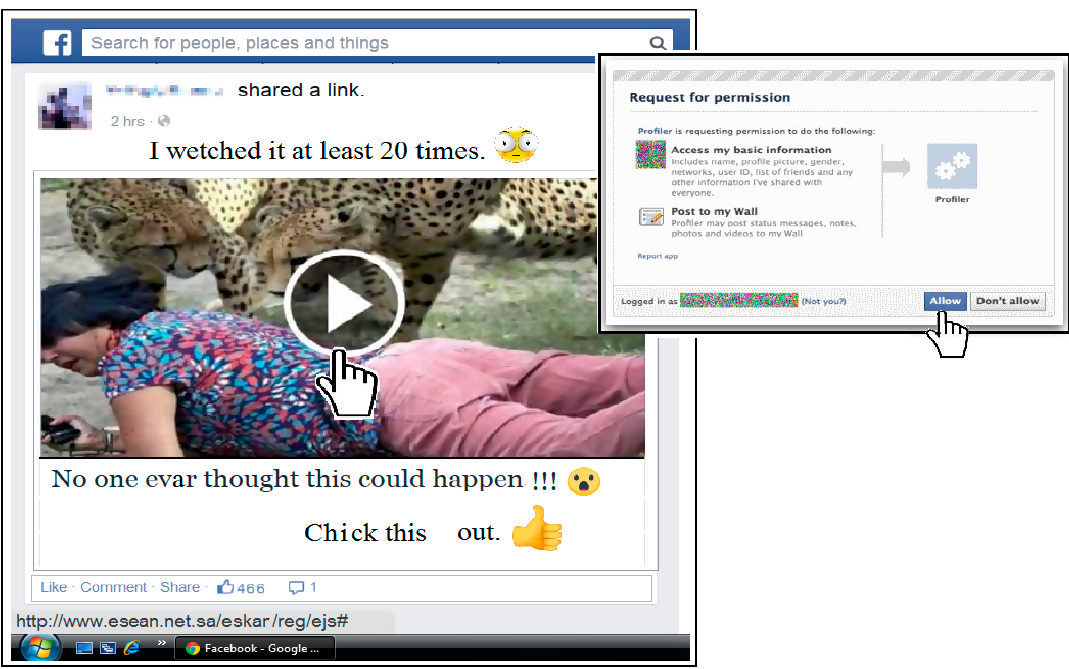
Figure A1. Experiment’s Example.